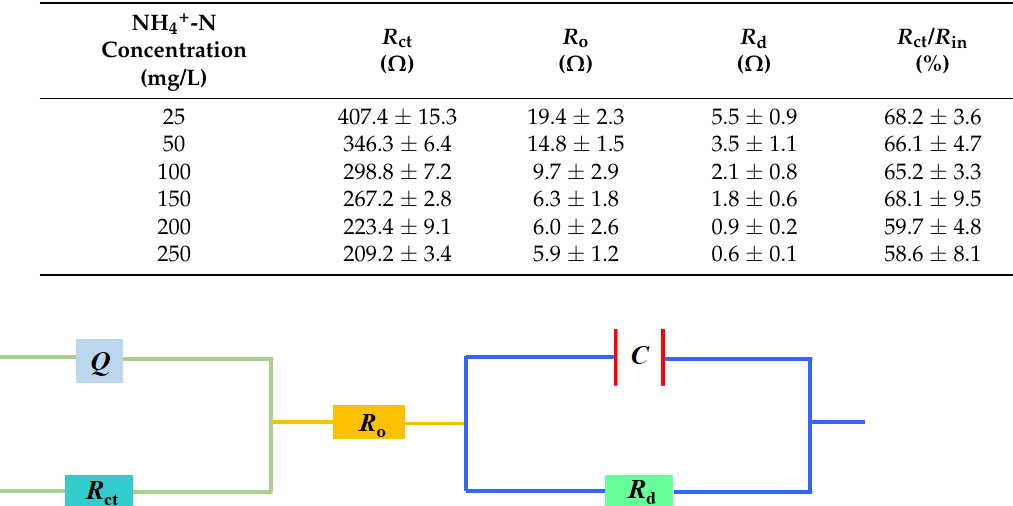
Figure 7. Nyquist plots of the anode under different influent concentrations. Table 2. Resistance distribution of the anode obtained from the equivalent electrical circuit.